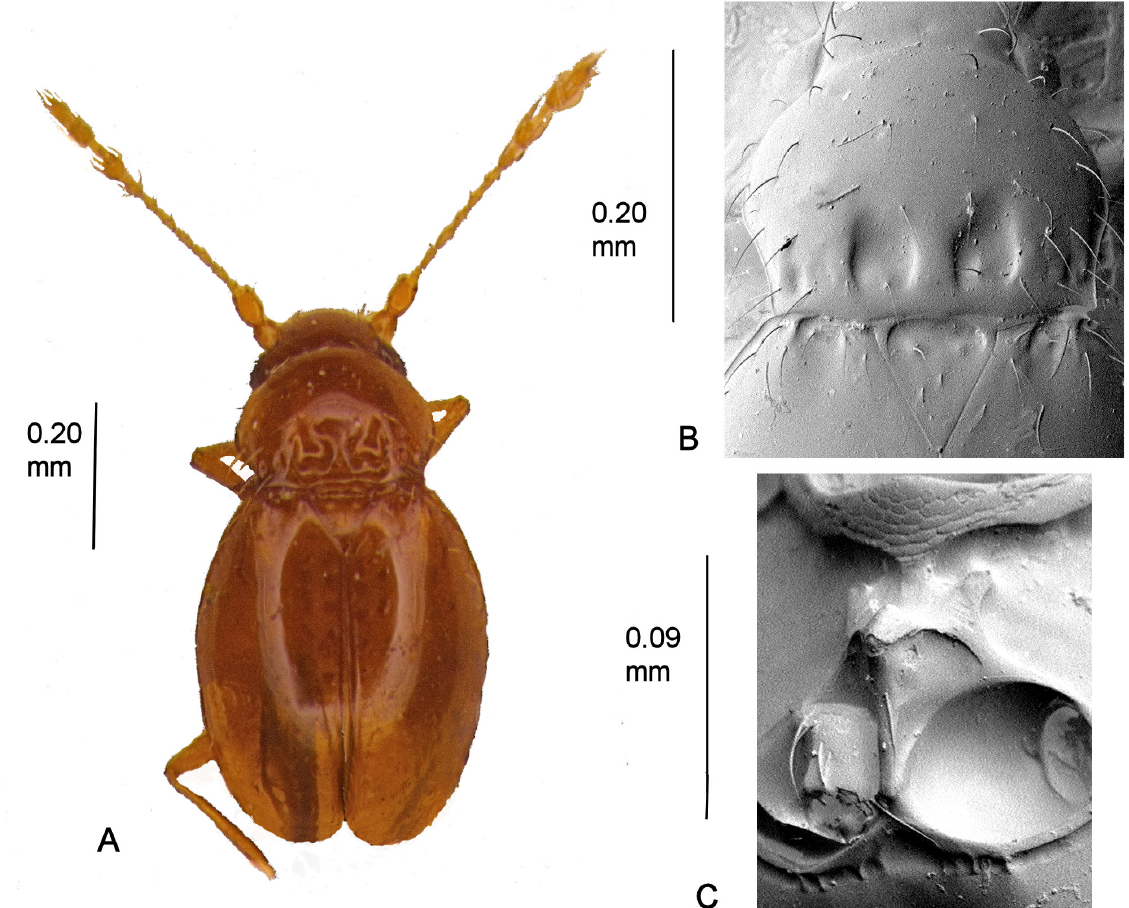
Fig. 17 . Cissidium bifoveolatum sp. nov. A . Habitus. B . Pronotum, × 620. C . Mesoventrite showing median process of collar, mid-keel and keel, ×